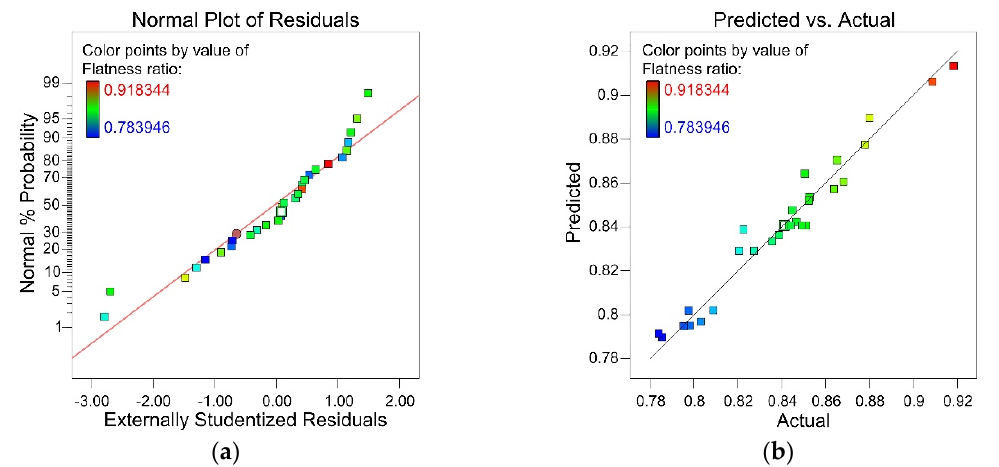
Figure 3. ( a ) Residual plot of flatness ratio; ( b ) Comparison of predicted and actual flatness ratio.